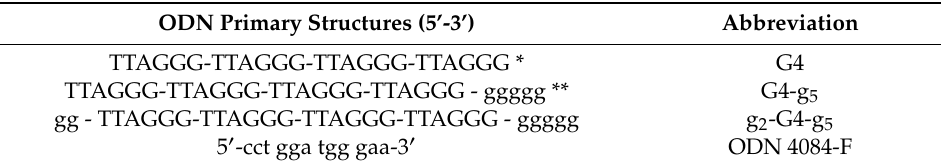
Table 1. Synthetic ODNs used in this